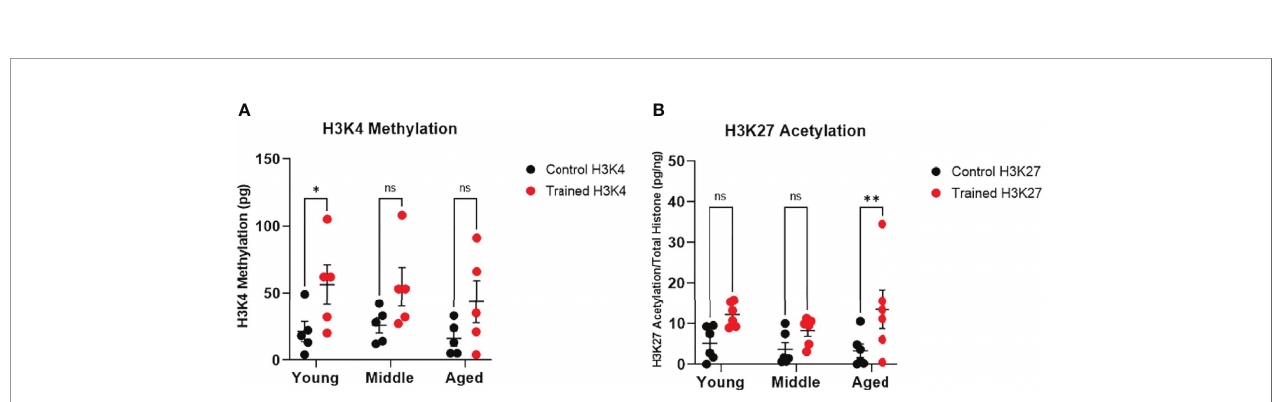
FIGURE 4 | Immune training differentially stimulates monocyte histone modi fi cations. (A) H3K4 methylation measured in situ 7 days after immune training with b – glucan or baseline control (N=5). (B) Histone H3K27 methylation 7 days after immune training with b – glucan or baseline control (N=6). All measured were analyzed with a mixed effect model and S ̌ ı ́ da ́ k ’ s multiple comparisons test (*P ≤ 0.05, **P ≤ 0.01, ns, not signi fi